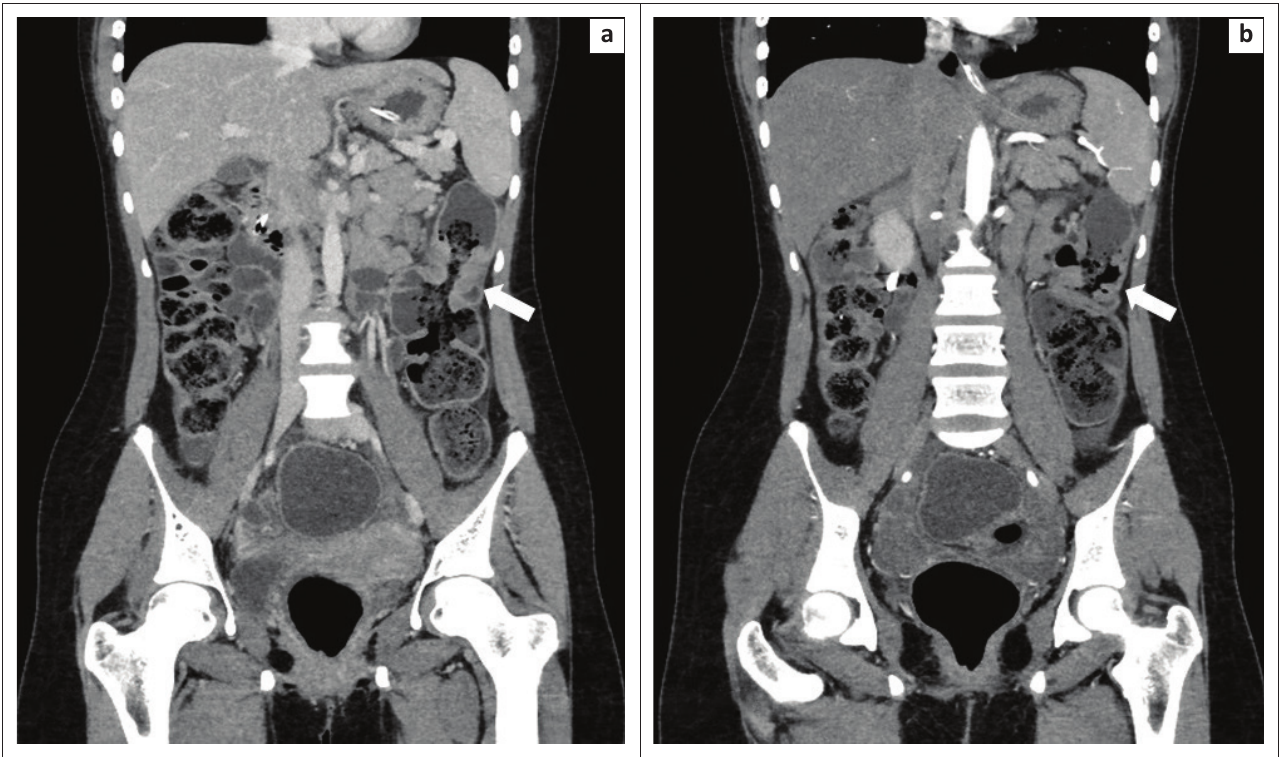
FIGURE 9: (a and b) Coronal reformatted computed tomography images of a 19-year-old female with a history of repeatedly chewing her ‘dupatta’ (a shawl-like scarf traditionally worn by women of the Indian subcontinent) showing a short segment of bowel wall thickening in the proximal descending colon (arrows). The ‘faecal like’ material within the lumen of the affected descending colon was identified at laparoscopy as textile bezoar.